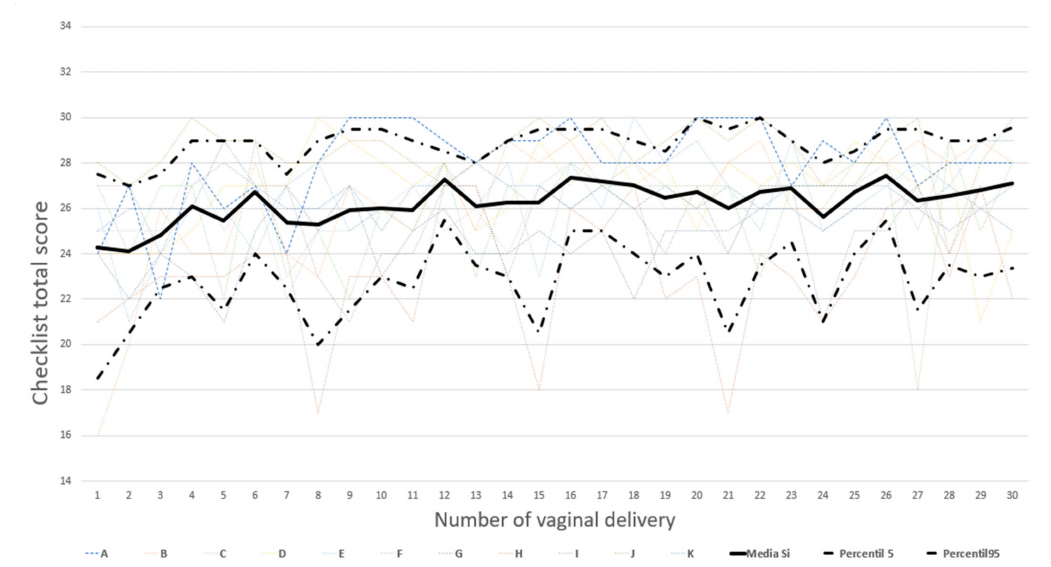
Figure 3. Mean CL completion for each delivery by all participants (mean of “Yes” answers for each completed CL during the first 30 deliveries). The global mean (continuous black line) of the first 30 deliveries of all participants is shown. The dashed black lines represent the 5th and 95th percentiles of mean CL completion in the first 30 births for all participants. The rest of the dashed lines of different colors reflect the individual trajectory of each participant during their care for their first 30 deliveries.